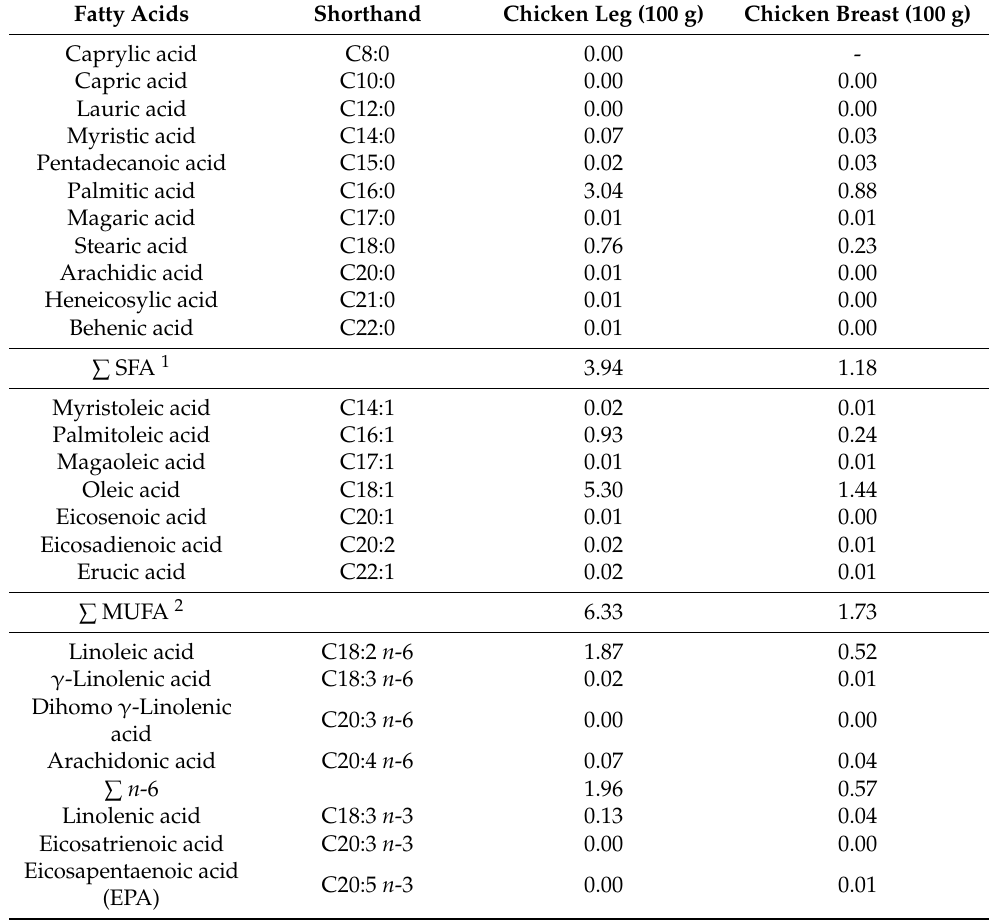
Table 5. Fatty acid composition of processed chicken leg and